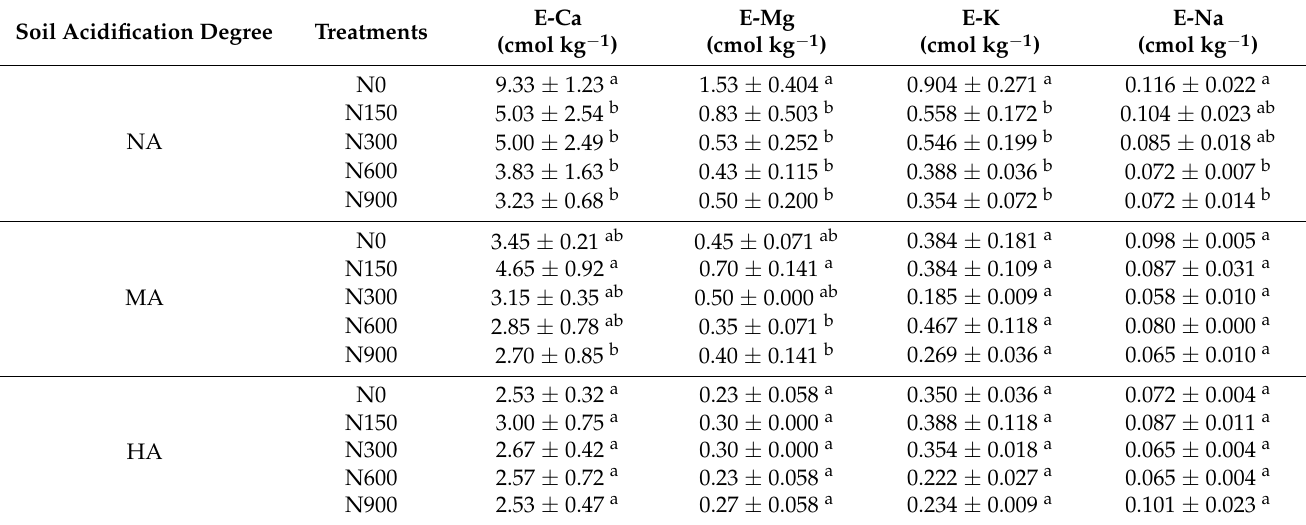
Table 5. Effects of N application rates on EBCs at tea plantations with different degrees of